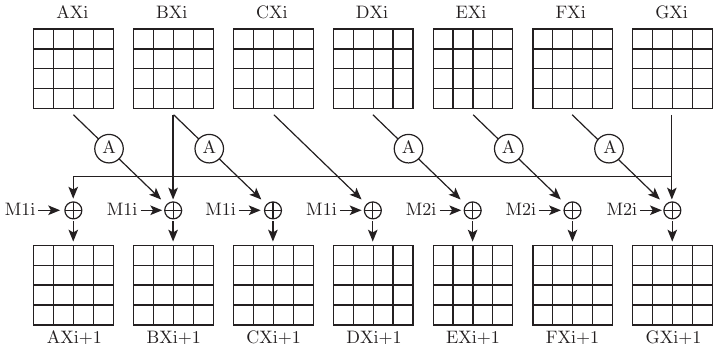
Figure 2: C5 construction. ‘A’ represents AES round